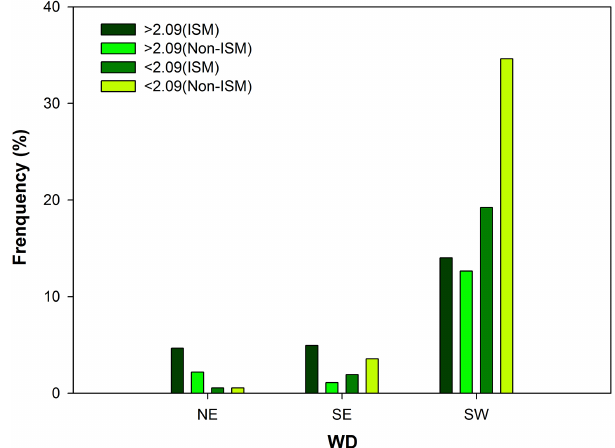
Figure 3. Distribution frequency of TGM above and under the aver- age (2.09ngm − 3 ) based on wind direction during the ISM and the non-ISM period. The high and low Hg levels of the SW frequency was higher than both the high and low Hg levels of the NE and SE